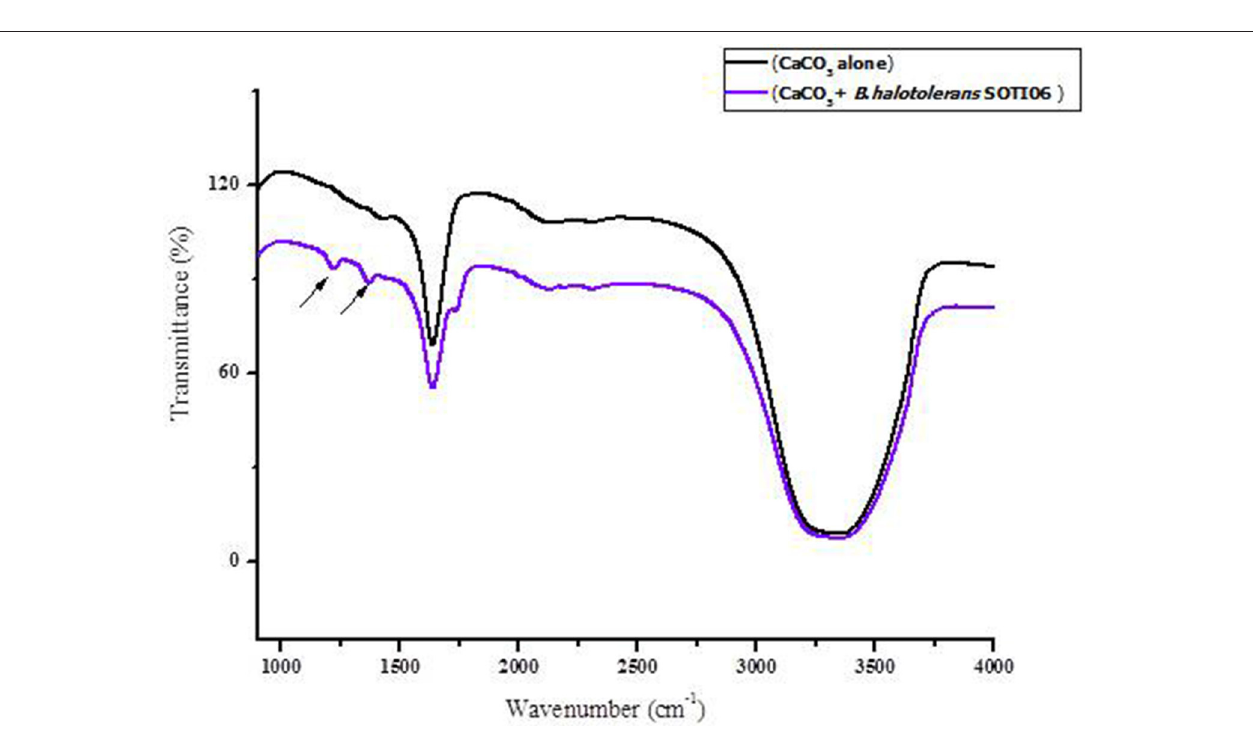
for instance, calcite and dolomite dissolution was studied in Shewenella oeindeisis MR1 (Davis et al., 2007), Bacillus subtilis, and Burkholderia fungorum (Friis et al., 2003; Jacobson and Wu, 2009). Recently, Brevibacterium sp. was isolated from Krast